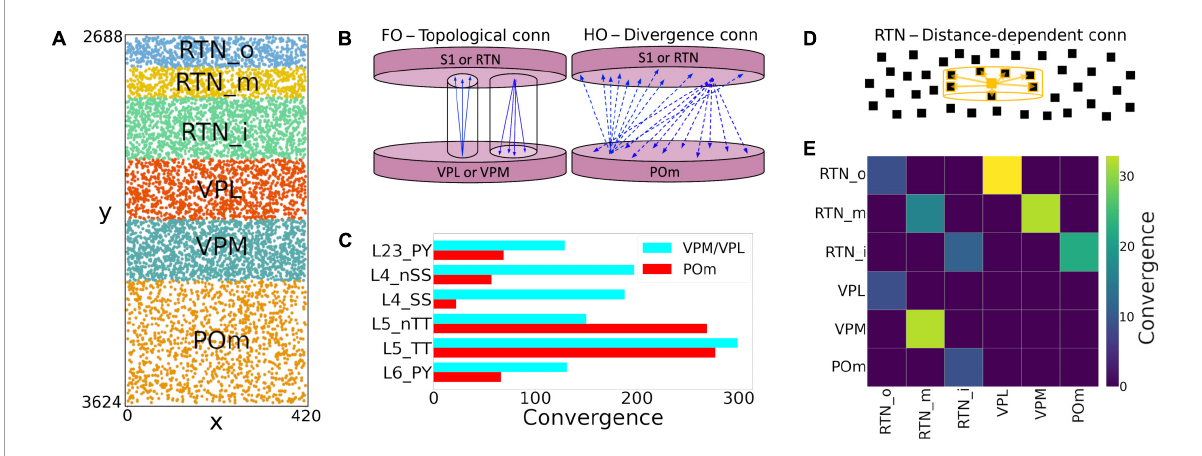
FIGURE4 NetPyNE model of somatosensory thalamic populations and connectivity extending the original S1 model. (A) Distribution of neurons across the six different thalamic populations, roughly mimicking the thalamus anatomy (x and y axes in µ m). (B) Schematic of bidirectional connectivity between thalamic regions and cortex. Bidirectional connections between S1/RTN and first order (FO) regions VPL and VPM are topological, whereas those with high order (HO) region POm are non-topological and implemented using divergence rules. (C) Convergence connectivity between thalamic regions and S1 (D) RTN cells have sector-specific distance-dependent connectivity (E) convergence connectivity matrix across all thalamic